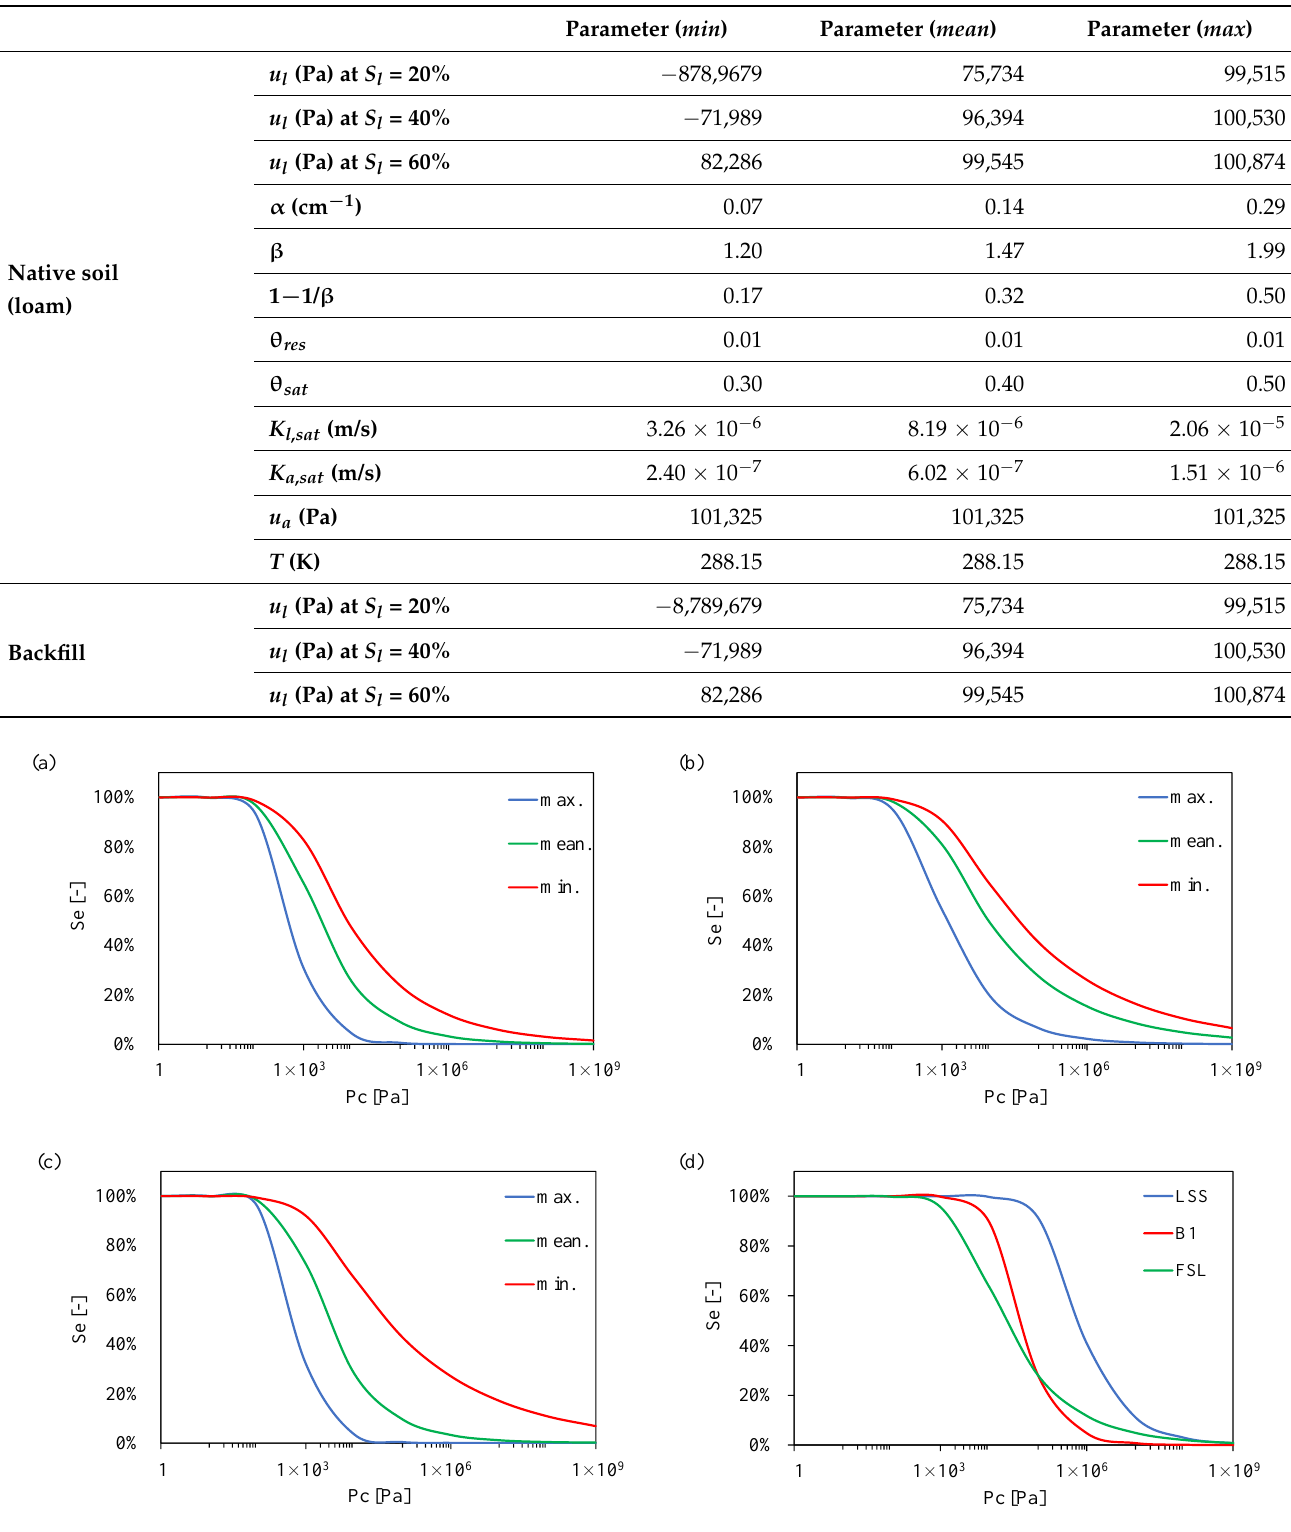
Figure 7. SWRCs for native soils of ( a ) BRU ( b ) LT ( c ) DP and ( d ) backfill materials.